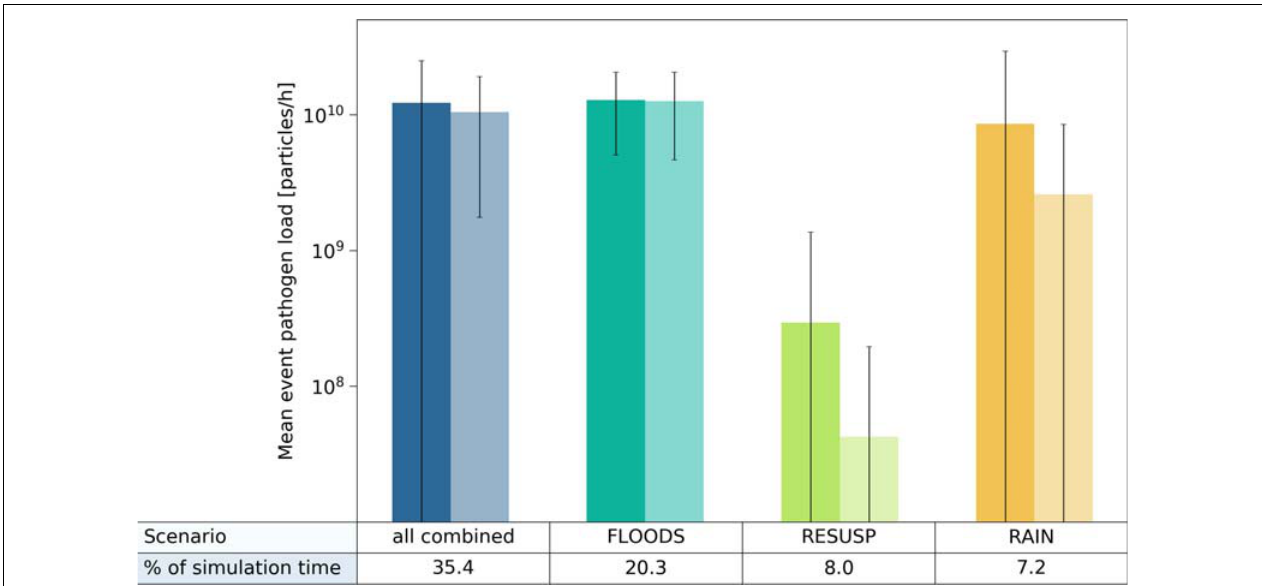
FIGURE 8 | Mean load attribution of Cryptosporidium (left columns) and Giardia (right columns) via (i) the discharge of Danube water (FLOODS), (ii) the resuspension from fecal deposits in inundated areas (RESUSP), (iii) the rainfall-release and runoff from fecal deposits (RAIN), and all scenarios combined from 2010 to 2015. Whiskers indicate the standard